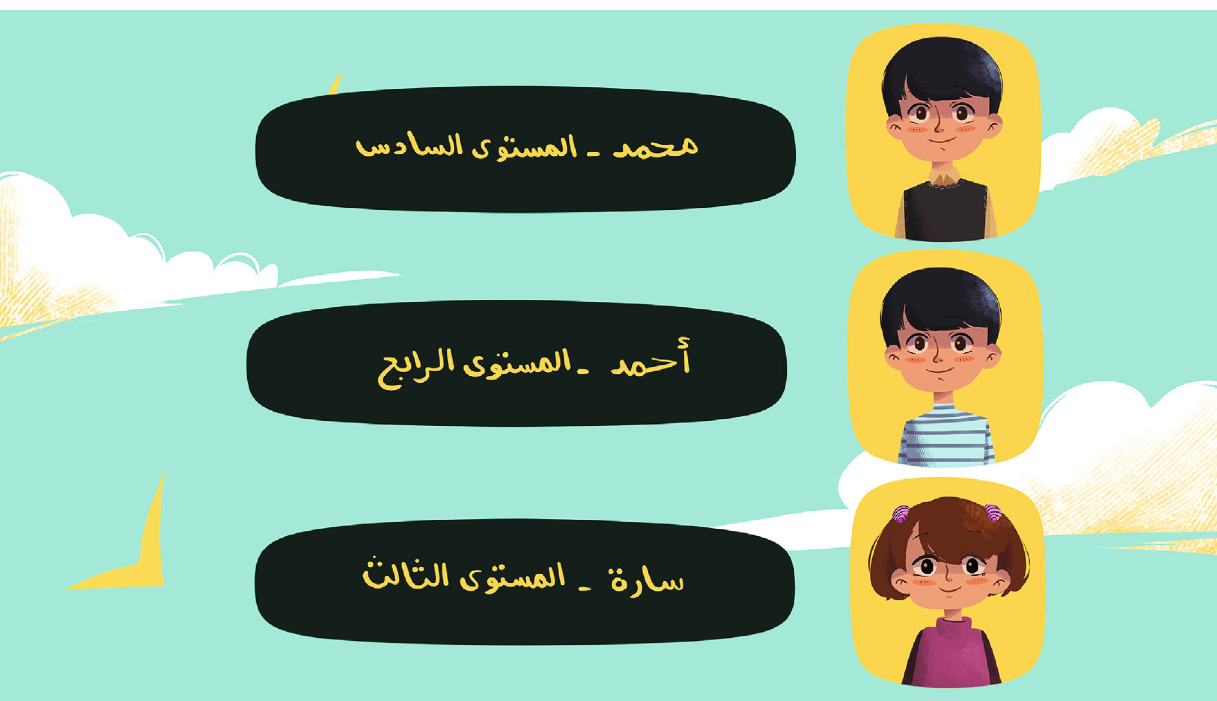
Figure 6: Friends ’ ranking